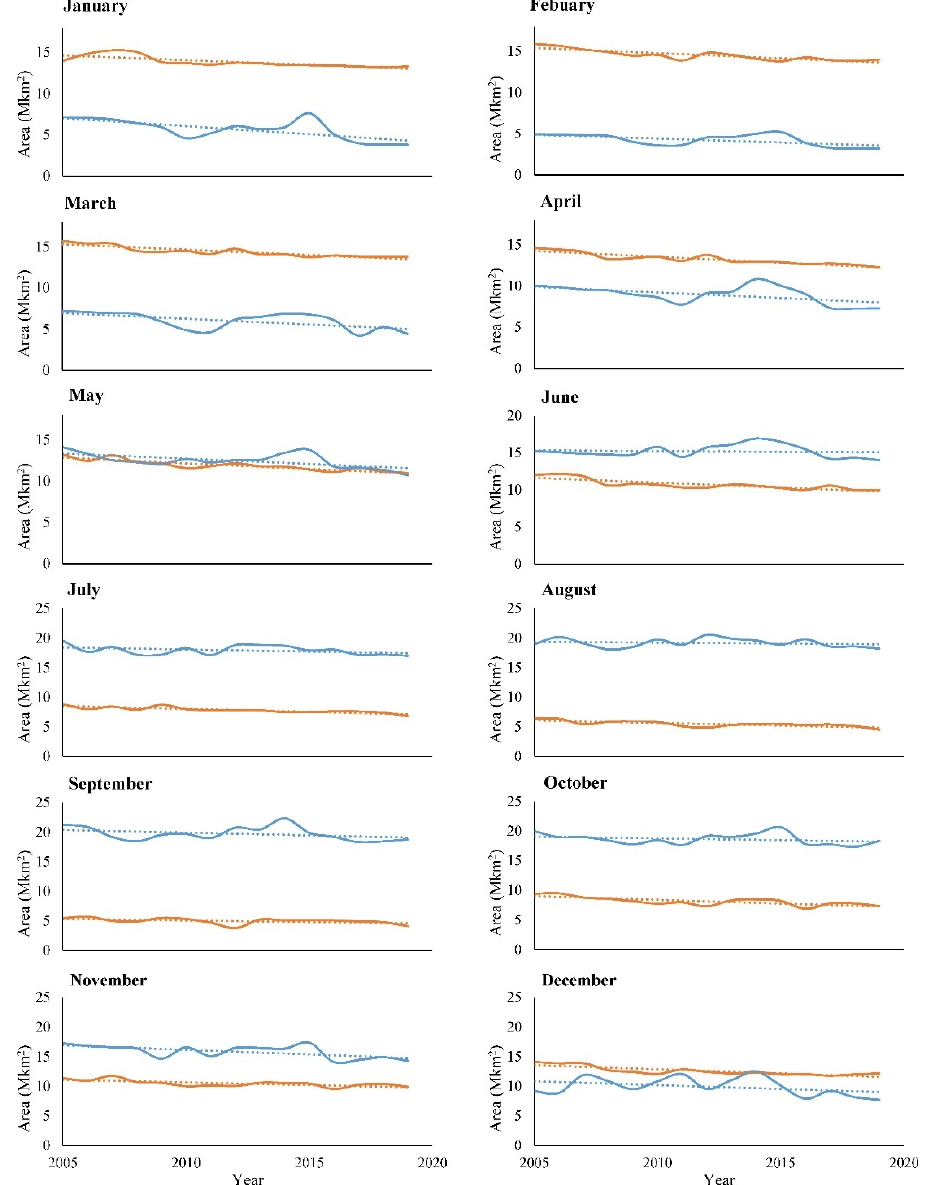
Figure 3. Monthly changes in ice sheet area over the — Arctic and — Antarctic regions during the 2005–2019 period.